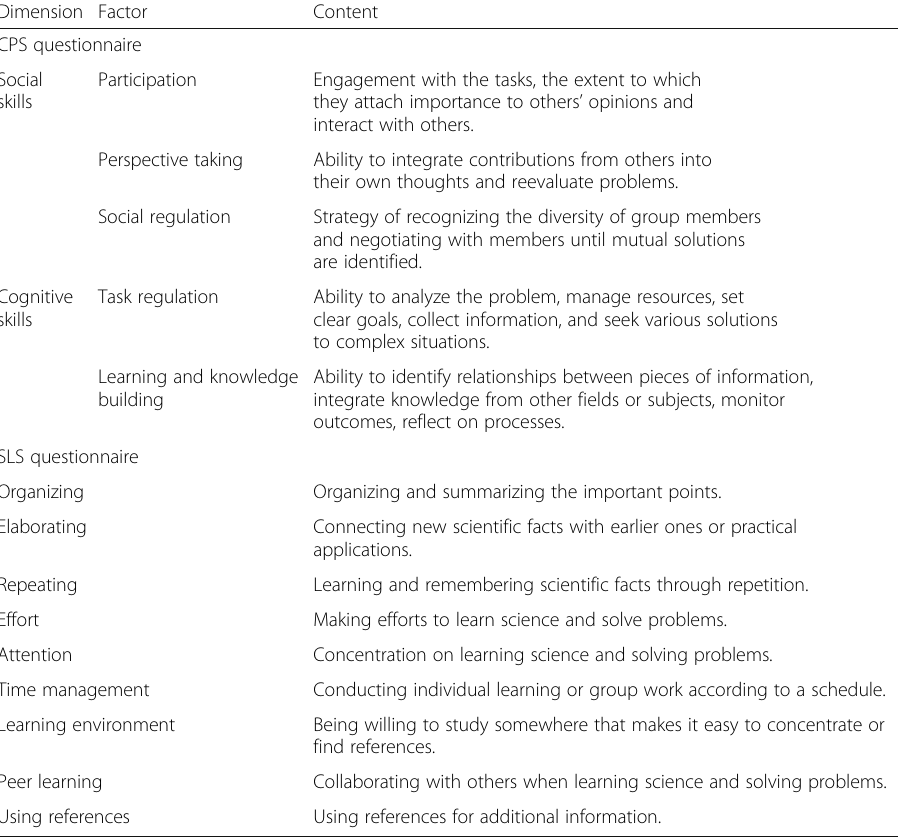
Table 1 Contents of the CPS and SLS questionnaires Dimension Factor Content CPS